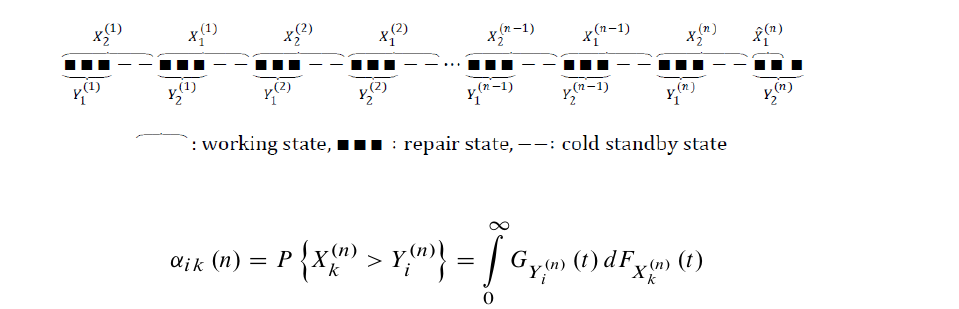
Fig. 2. A diagram for event B n in cycle n